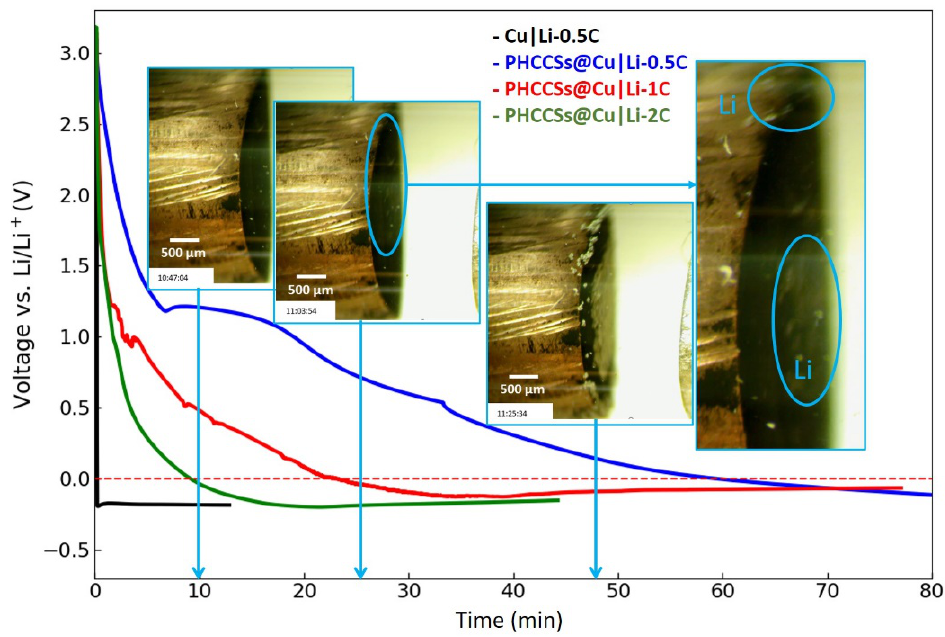
Figure 4. The voltage vs. time profile of Cu|Li and PHCCSs@Cu|Li. The images provided show the deposition of lithium in PHCCSs@Cu|Li optical cell during the lithium deposition process (c-rate of 1C; the blue circles show the locations where plated lithium first appears).